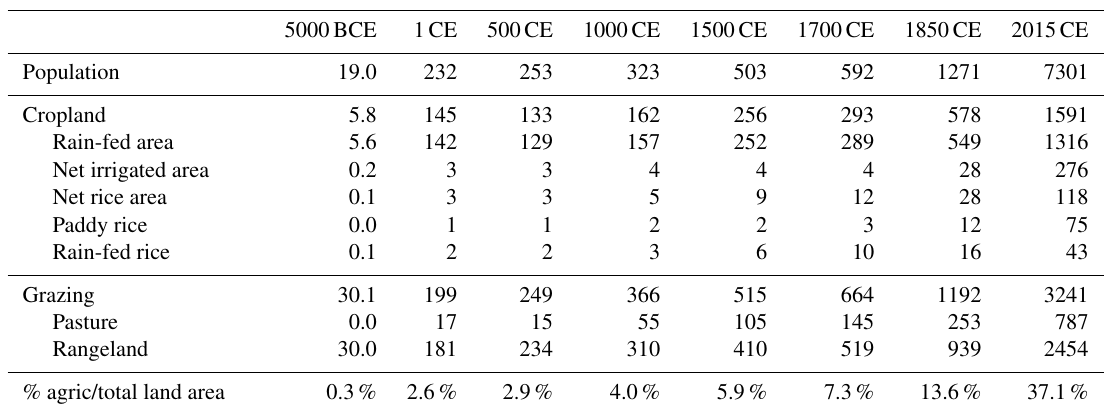
Table 6. Summary of global population and land use